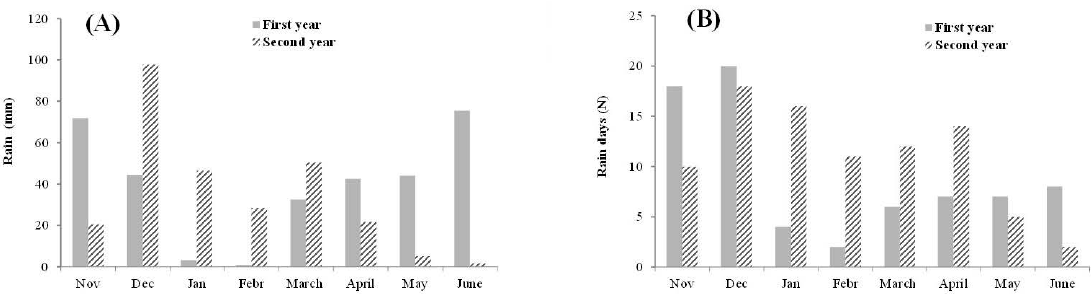
Figure 1. Total precipitation ( A ) and rainy days ( B ) per month during the two-year trial of the durum wheat